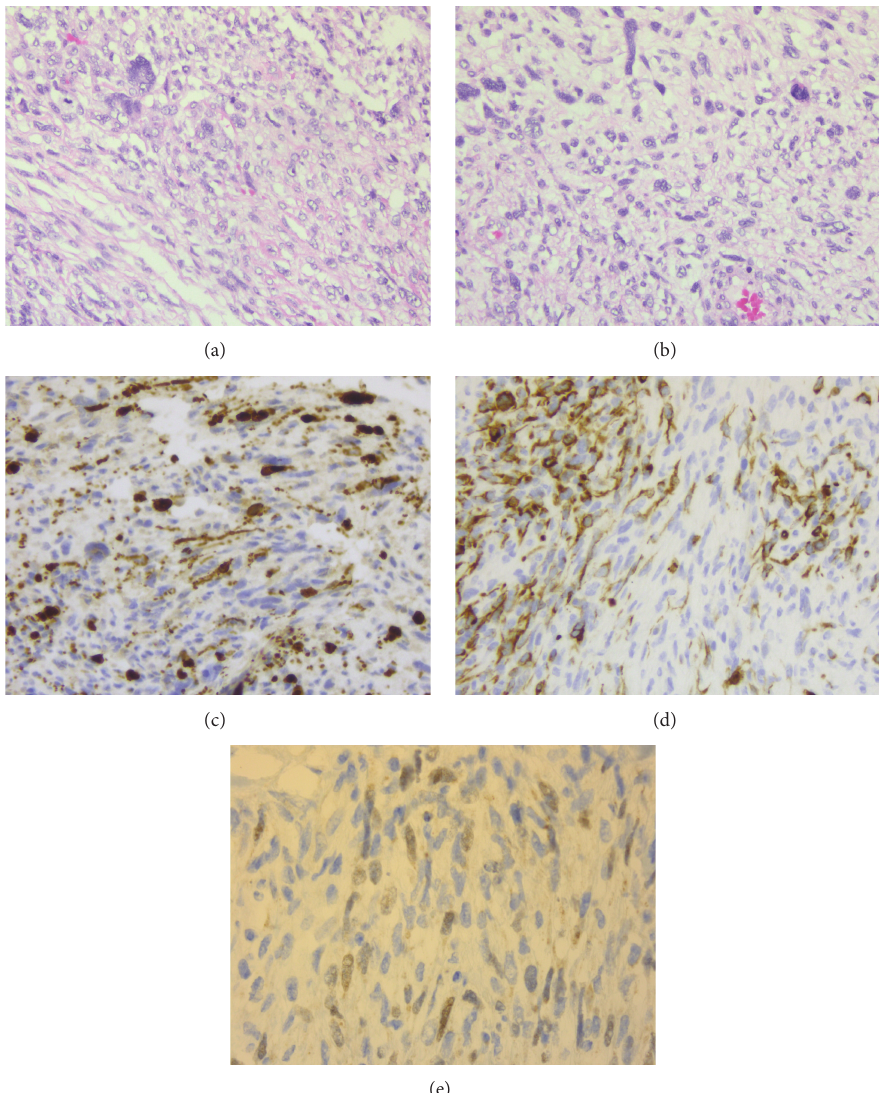
Figure 2: (a) and (b) Malignant triton tumor (MTT) cells. Tumor cellularity and spindle shaped pleomorphic cells are apparent. Interspersed eosinophilic muscle fibers are within the field (H&E). (c) Positive immunohistochemical stain with desmin highlighting presence of striated muscle within tumor. (d) Positive immunohistochemical stain with S-100. This verifies the presence of neural component within the tumor. (e) Positive immunohistochemical stain with MyoD transcription factor demonstrating myogenic component of